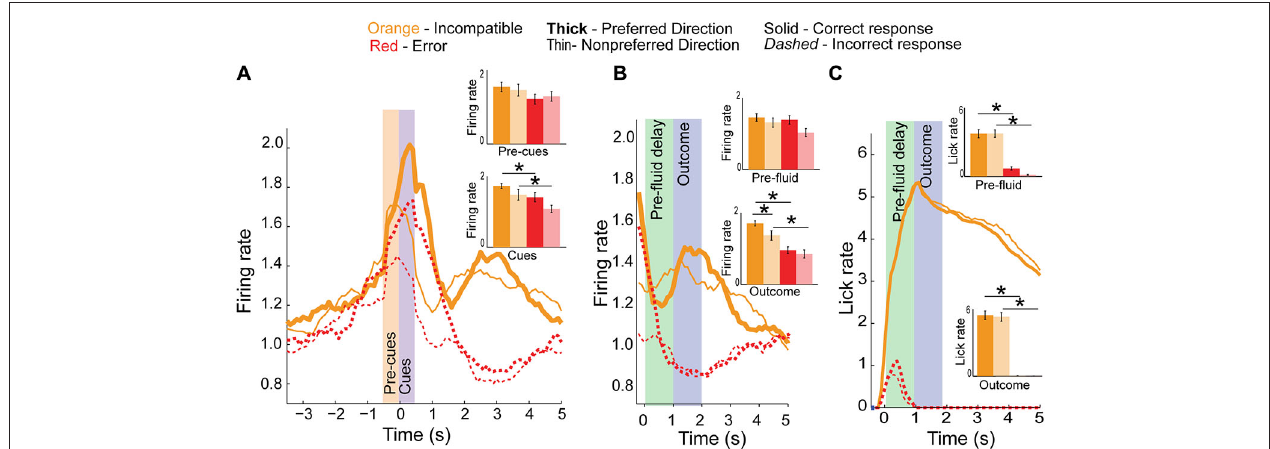
FIGURE 7 | Conflict activity on error trials. (A) Population histogram of conflict neurons on incompatible trial-types (orange) plotted by direction (full color are preferred direction, faded color are non-preferred directions in bar graph insets) showing decreased neural activity on error trials (dashed red or faded red for inset bar graphs) during the cue epoch. (B) Aligning data to fluid-well entry demonstrates a significant reduction in activity during pre-fluid delay and after reward should have been delivered, suggesting these neurons also represent the outcome of the trials. (C) Licking did not significantly differ between directions. Significance denoted of at least p < 0.05 with asterisk ∗